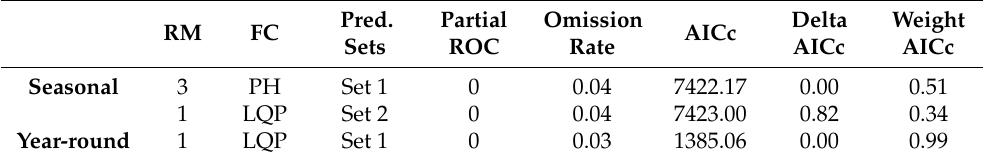
Table 1. Summary of performance statistics of best models for predicting seasonal and year-round distributions of Bactrocera dorsalis . The relative regularization multiplier (RM), feature classes (FC), sets of predictors (Pred. Sets), and AICc values are shown. Delta AICc and weight AICc of models with default settings are relative to the selected models. Pred. RM FC